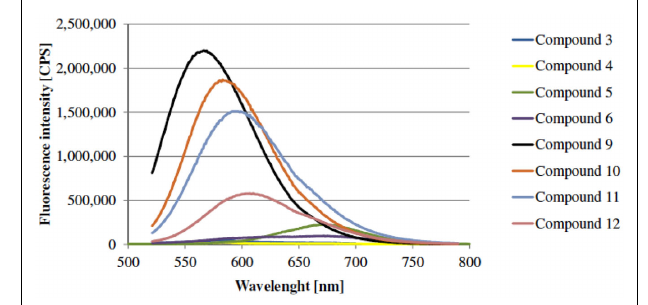
FIGUREA2 | Fluorescence emission spectra of chalcone derivatives (Excitation wavelength: 405nm).